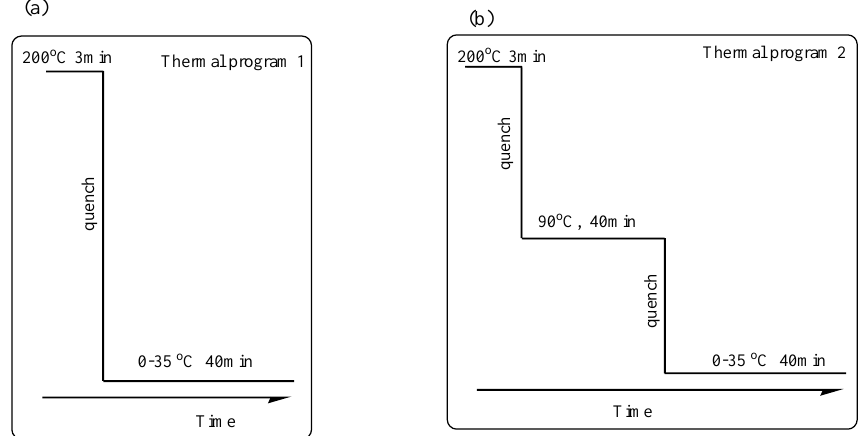
Figure 1. ( a ) Thermal program 1 and ( b ) thermal program 2 applied in DSC and WAXD analyses.